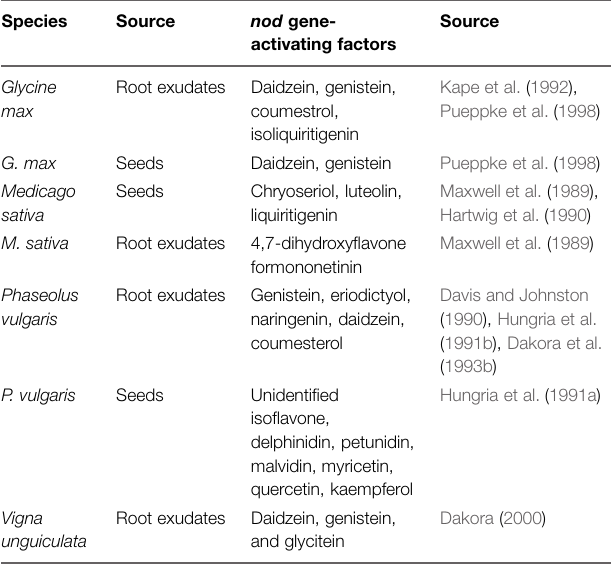
TABLE 1 | Seed and root exudate compounds with known nod gene-activating factors, from legumes with broad or narrow ranges of symbiotic